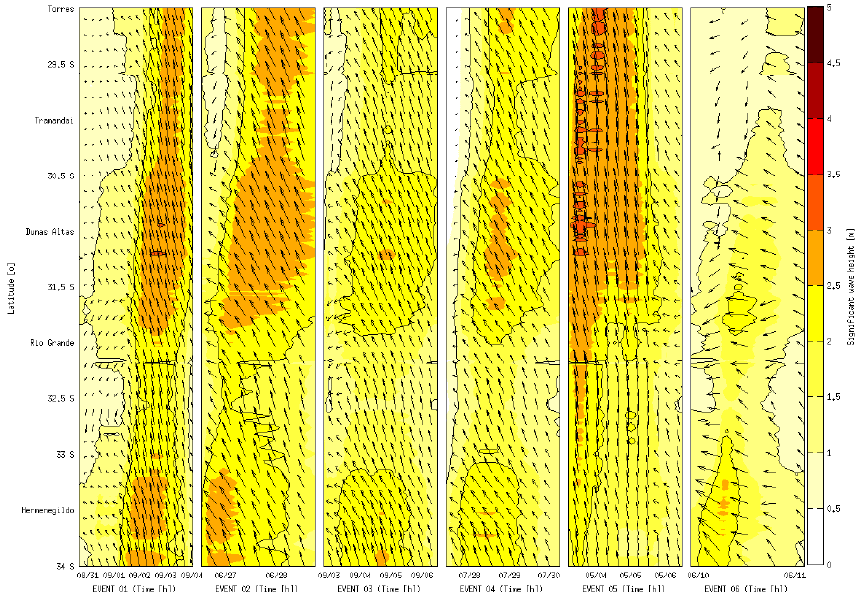
Figure 6. Hovmöller diagram for shallow water waves. The diagram displays the wave parameters H s and D p for 6m isobathymetry. The latitude of the wave is displayed along the y axis, and the time is shown along the x axis. The H s are on a color scale and the D p are shown as